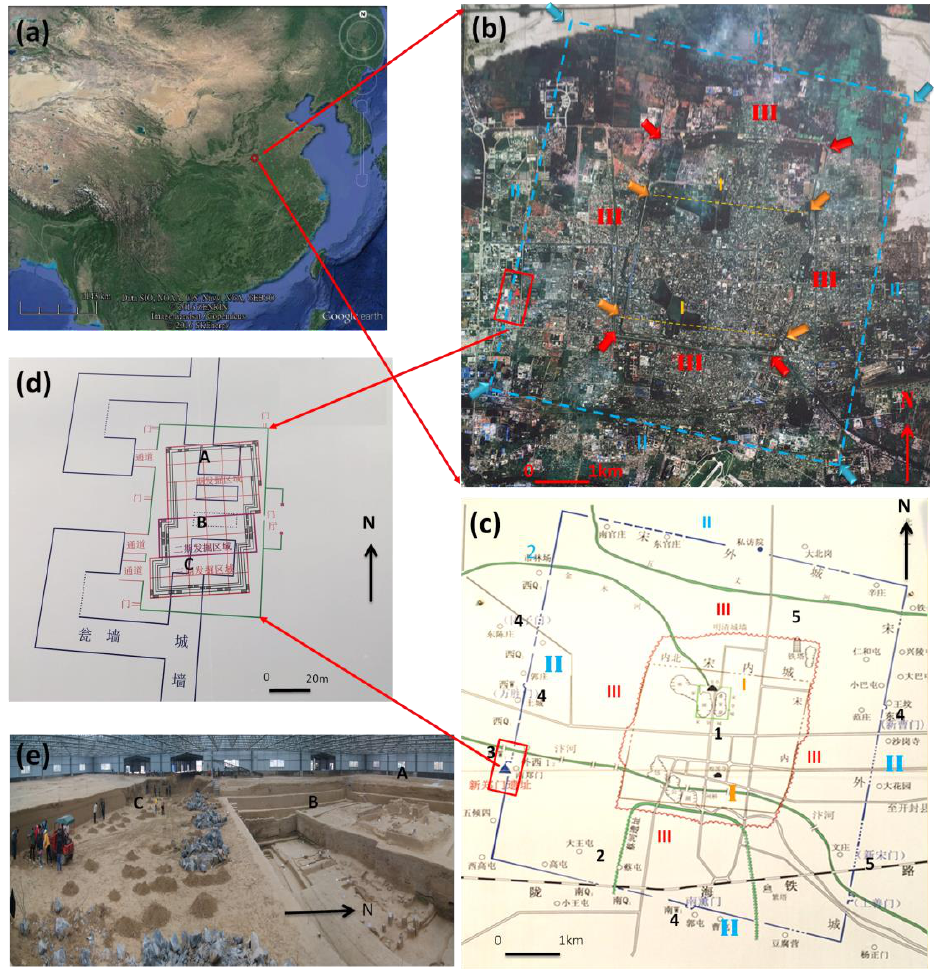
Figure 1. ( a ) Location of Kaifeng from a satellite image. ( b ) Kaifeng city with the indication of city walls and the investigated area. ( c ) Map of Kaifeng city walls, the main historical buildings and the investigated area. In detail: I: Northern Song inner city wall (hypothesis with some evidences); II: Northern Song outer city wall (hypothesis but some evidences); III: Ming and Qing city wall; 1: Northern Song Imperial Palace; 2: Cai river site; 3: investigated area near Xinzheng Gate; 4: Northern Song gates; 5: Iron tower. ( d ) Map of Xinzheng gate with the indications of the excavated areas: A, B and C. The latter has been excavated after geophysical prospection. ( e ) Photo of the archaeological area of Xinzheng, in November 2015 before geophysical investigations. Please note that A and B refer to past excavations which unearthed a section of Northern Song city walls (in B) and a rural building dated to Qin Dynasty (in A).